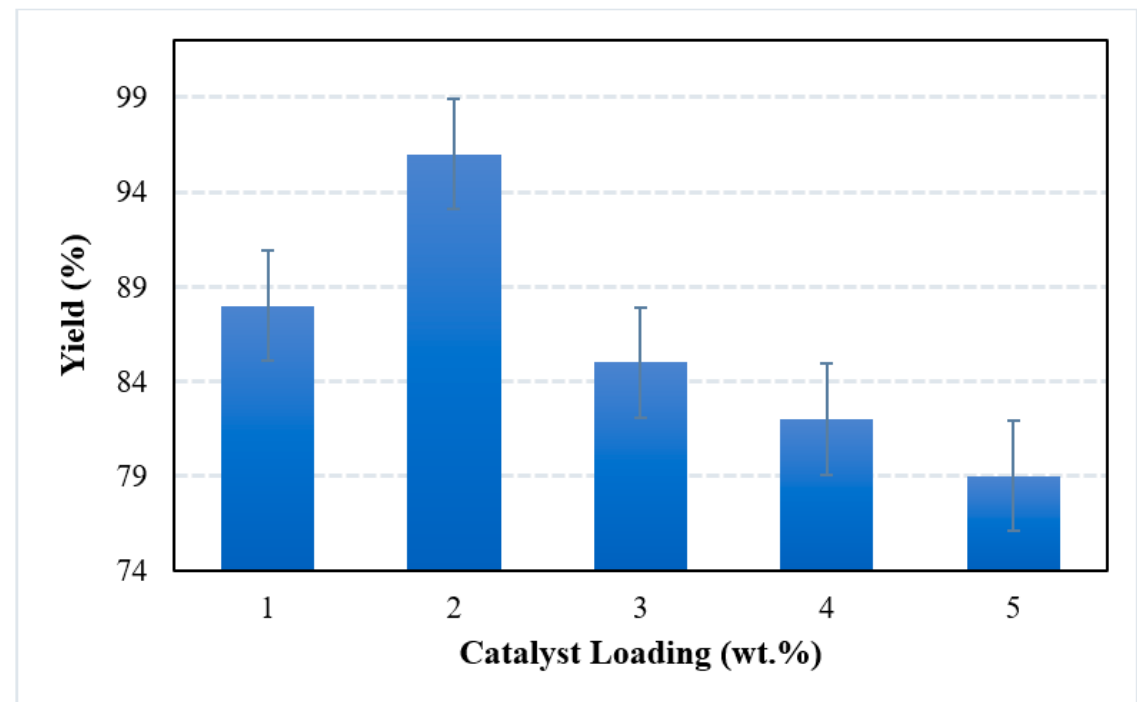
Figure 7. Effect of catalyst loadings on biodiesel production.